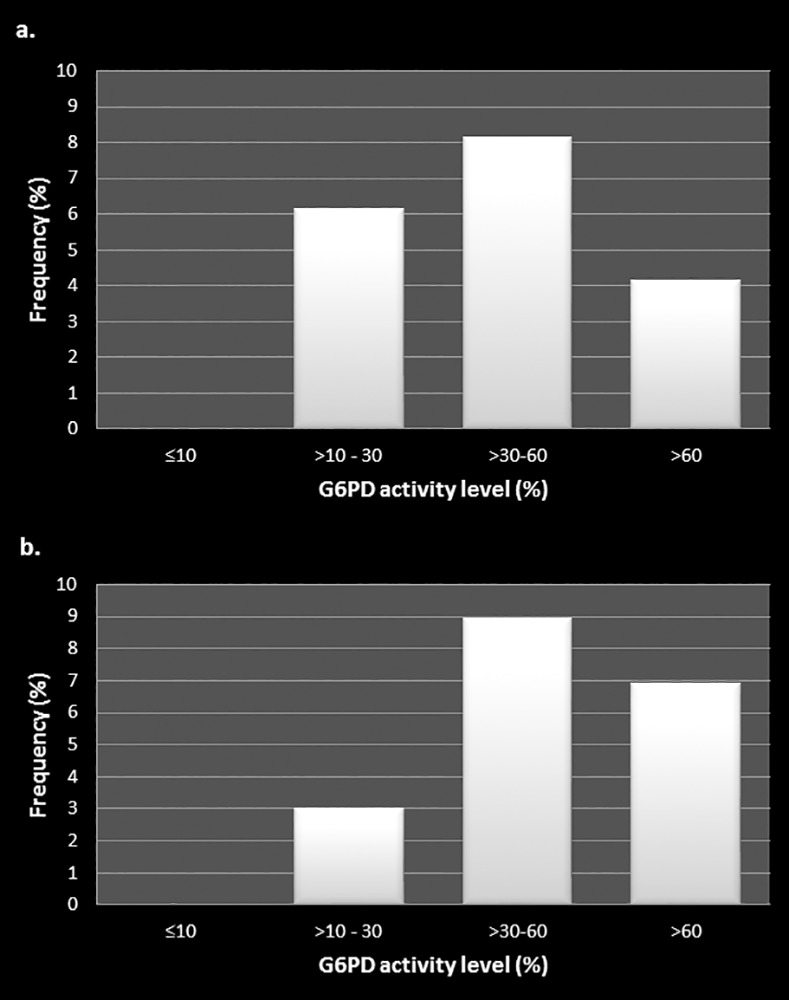
Colour code discrepancies between observers at varying G6PD activity levels in samples from Anuradhapura district (a) and Kurunegala district (b).